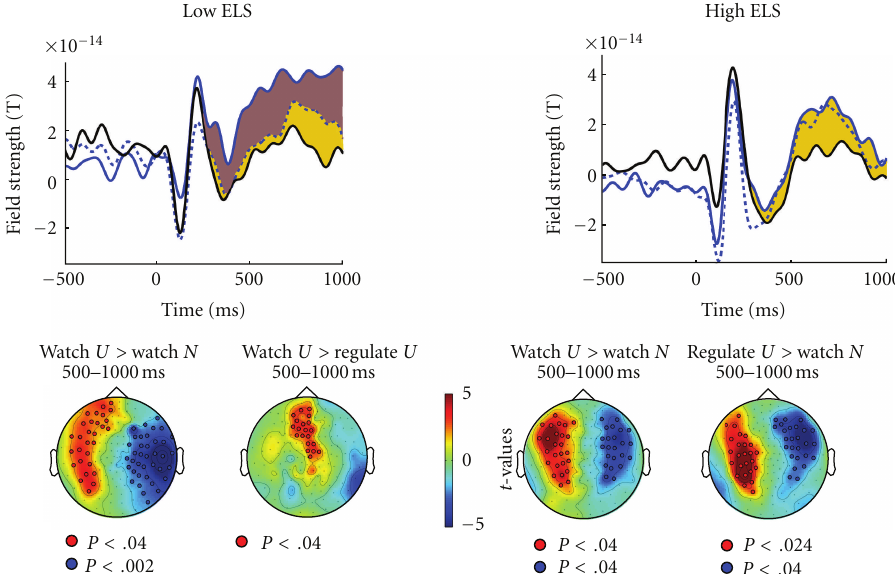
Figure 4: Top: time course of field strength around picture onset at 0ms (as in Figures 1(a) and 2(a)) for patients with low childhood stress load ( N = 15, left graph, low ELS = early life stress) and patients with high childhood stress load ( N = 15, right graph, high ELS). Yellow shading marks epoch of significant Emotion e ff ect. Brown shading marks epoch of significant Instruction e ff ect (present only in low-stress group). Bottom: t -maps projected onto schematic top views testing watch-unpleasant versus watch-neutral and testing watch- unpleasant versus down-regulate-unpleasant 500–1000 ms after picture onset. Red and blue colors represent sensor clusters which show significant ( P < . 01) di ff erences in field strength between conditions, with sensors defining the significant clusters marked by open circles (as in Figure